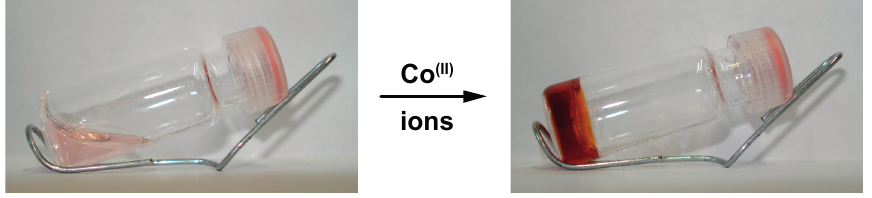
Co (II) Figure 5. Pictures of metallo-supramolecular hydrogels obtained from a P(DMAMEA 200 - co -TpyMA 4.5 ) copolymer solution upon the addition of cobalt(II) ions.